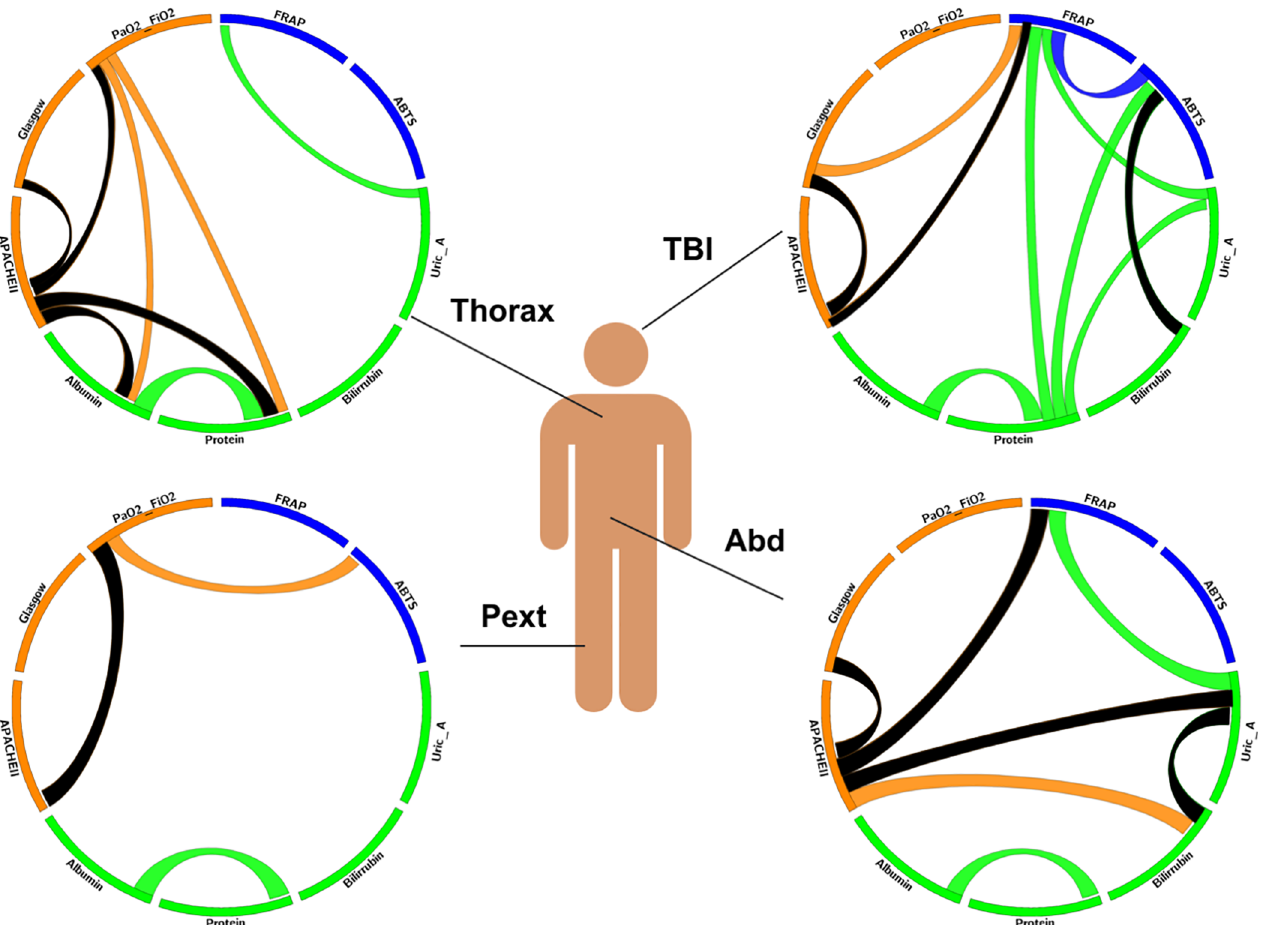
Fig 1. Cord diagrams showing that correlations between clinical, analytical and plasma antioxidant variables are dependent on trauma location. Individual (one for each location) Circos-type graphs show the degree of correlation, where circular segments denotate the variables evaluated and lines connecting them, the existence of significant correlations according to Spearman’s rank correlation test (p < 0.05); negative correlations are marked in black. Values used are those present in the first 48 h.